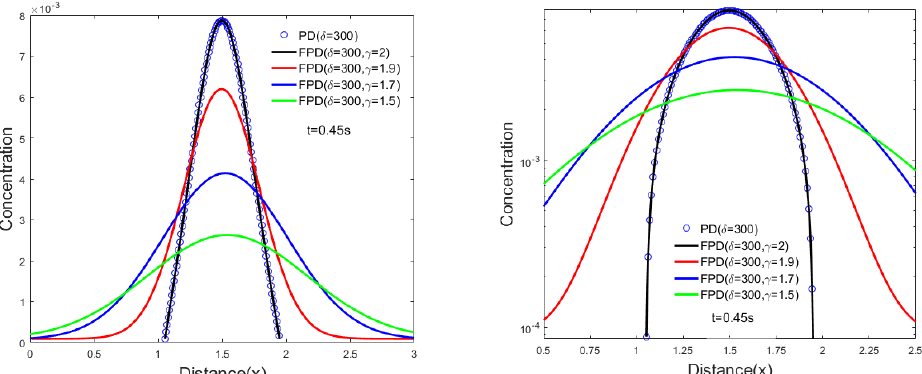
Figure 1. The concentration profiles using the peridynamic (PD) model and the fractional peridynamic (FPD) model with near-field range δ = m ( ∆ x ) = 300 at four different space fractional indexes: γ = 1.5, γ = 1.7, γ = 1.9, and γ = 2. Other model parameters were D α = 1.0, L = 3, and t = 0.45 s. The right plot is the semi − log form.